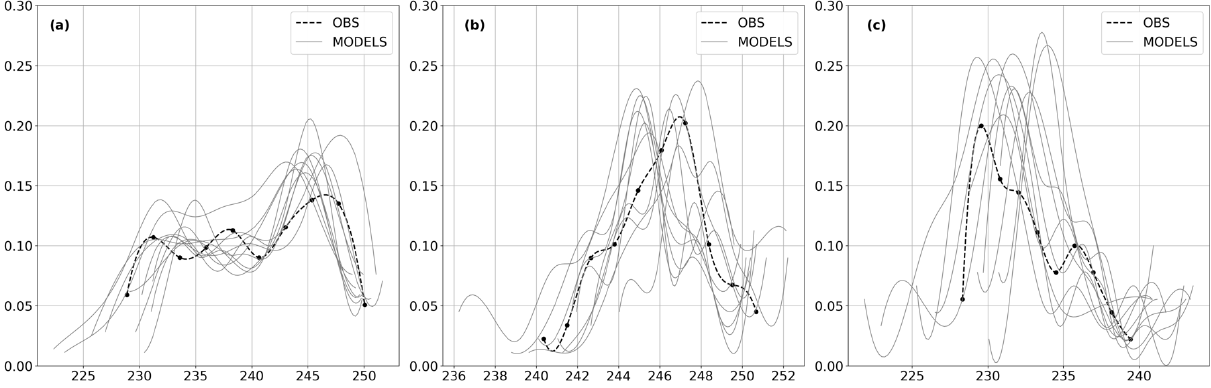
Figure 6. Probability density of observed (dashed black line) and modeled (solid gray lines) surface temperature for (a) all temperatures, (b) daytime (09:00–15:00LT) temperatures, and (c) nighttime (21:00–03:00LT)